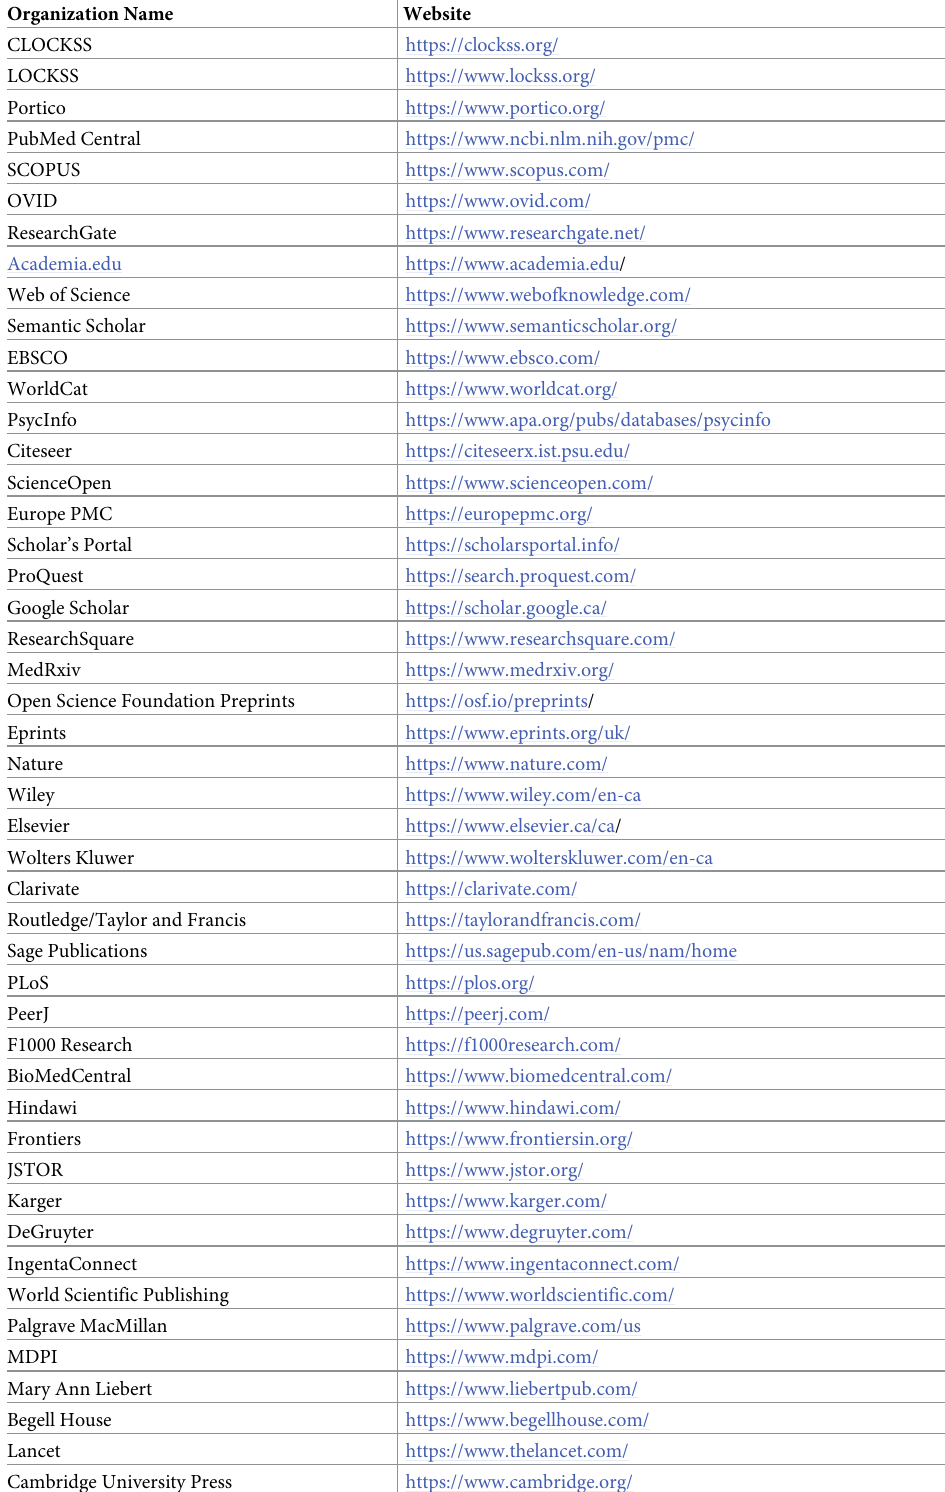
Table 2. List of grey literature